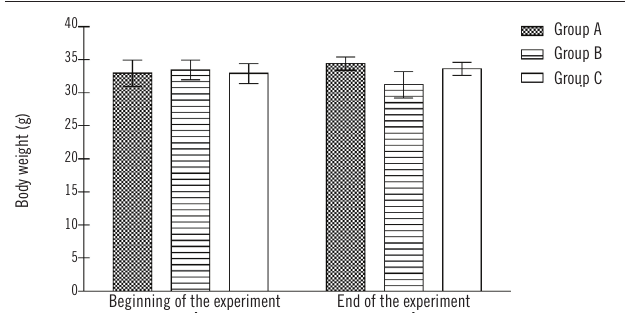
figurE 2 − Body weight Absolute values of the body weight of the mice at the beginning and at the end of the experiment. Group A: control; group B beginning of intake prior to tumor inoculation; group C: beginning of intake after tumor inoculation. Results expressed in mean and standard deviation with n = 6/group. There was no significant difference between the groups.